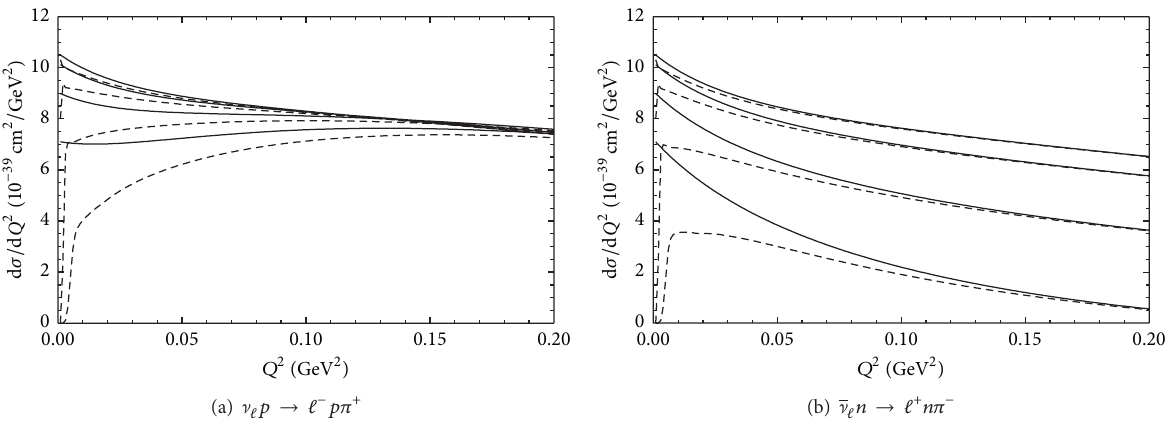
Figure 3: Comparison of muon and electron neutrino or antineutrino cross-sections for various energies 𝐸 ] , ] = 1,2,5,10 GeV (bottom to top). The solid line is for electron neutrinos or antineutrinos and the dashed one for muon neutrinos and antineutrinos, respectively.